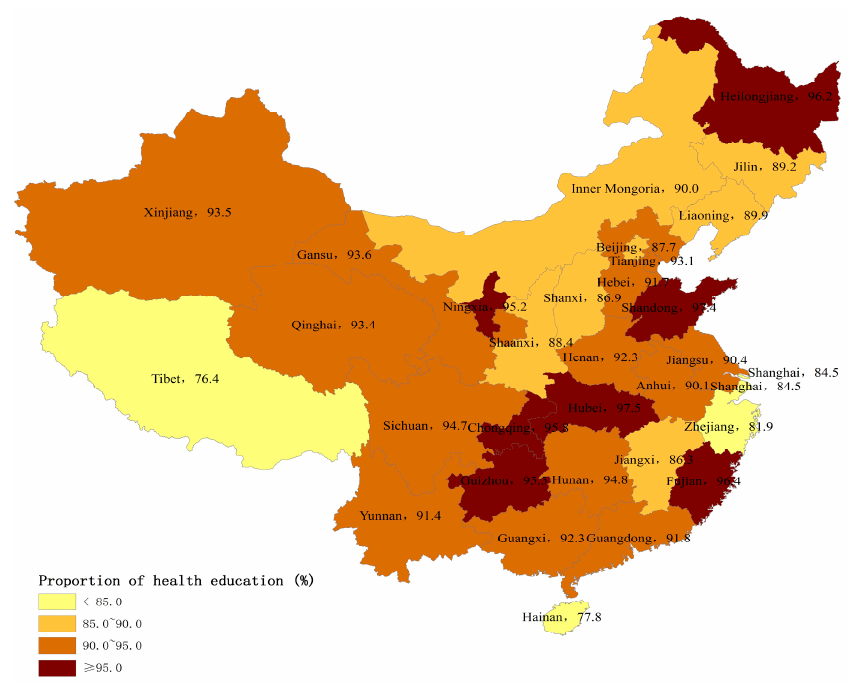
Figure 2. Percentage of internal migrants who had accessed health education by province, 2015 (%).